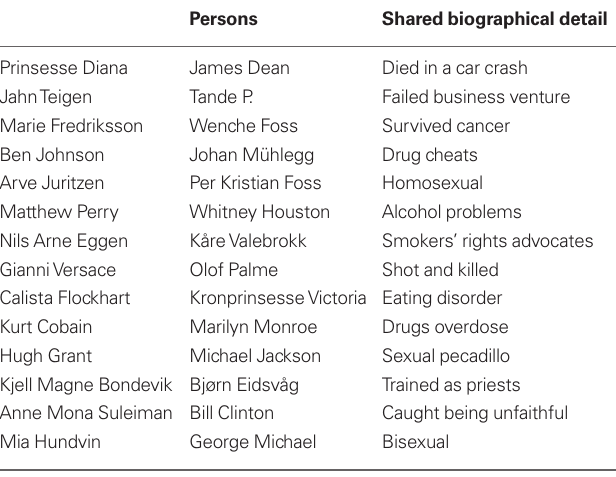
Table A5 | The related pairs of stimuli used in experiment 3, with their single related